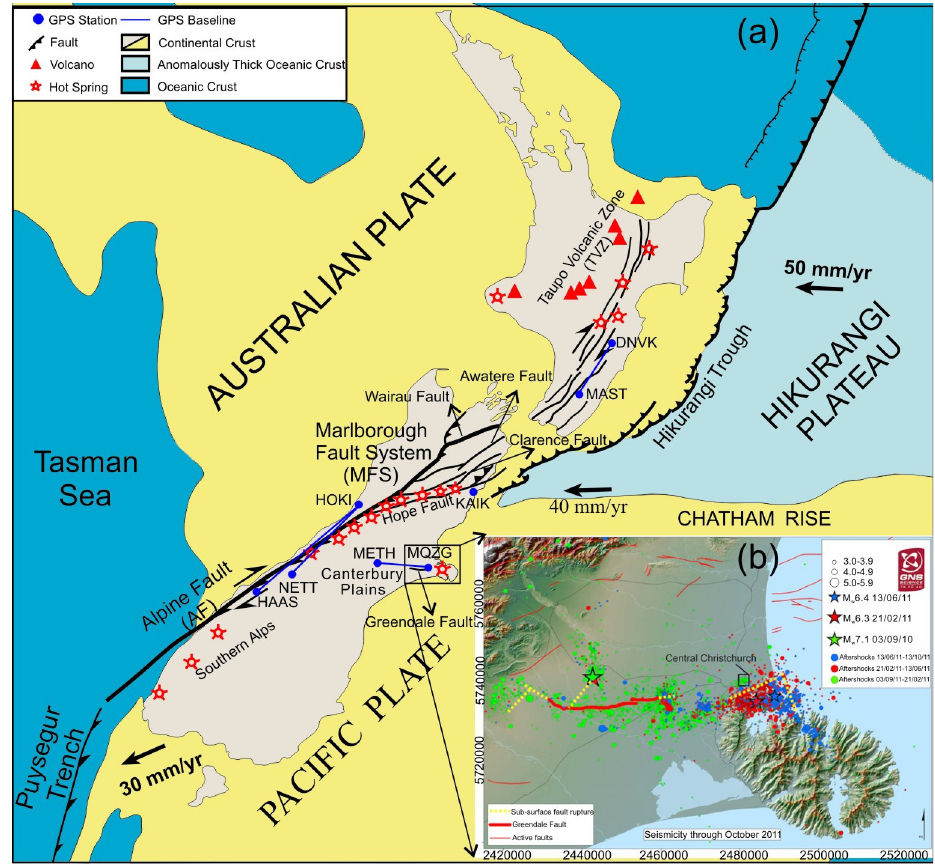
Fig. 1. Tectonic map in the seismic region of the 2010–2011 New Zealand earthquake sequence. (a) shows the main structural features of New Zealand associated with the obliquely convergent Australia-Pacific plate boundary zone (Provided by Jarg Pettinga, University of Canterbury); the fat-arrows indicate relative plates convergence direction, teeth lines indicate subductions, thin-arrows indicate strike-slip faults, and tick lines indicate normal faults. (b) shows the epicenter locations and the Greendale Fault (from GNS Science).